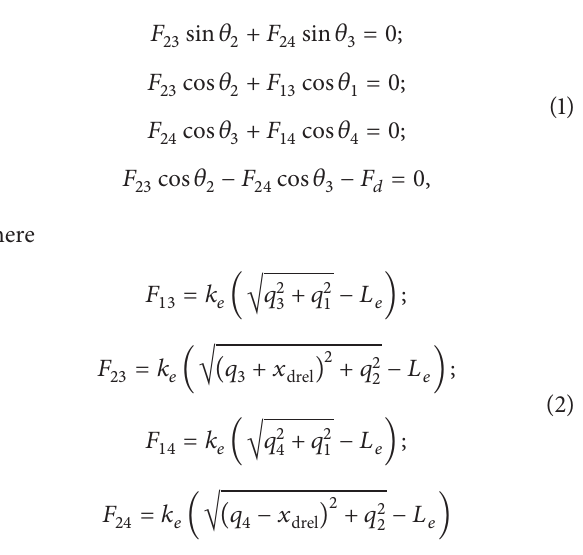
The coordinates of joints 1, 3, and 4 are denoted 𝑞 1 , 𝑞 3 , and 𝑞 4 , respectively. The 𝑥 and 𝑦 coordinates of joint-2 are and 𝑞 2 , respectively, with 𝑥 being the TMD denoted 𝑥 drel drel displacement measured relative to the top storey (Figure 2).